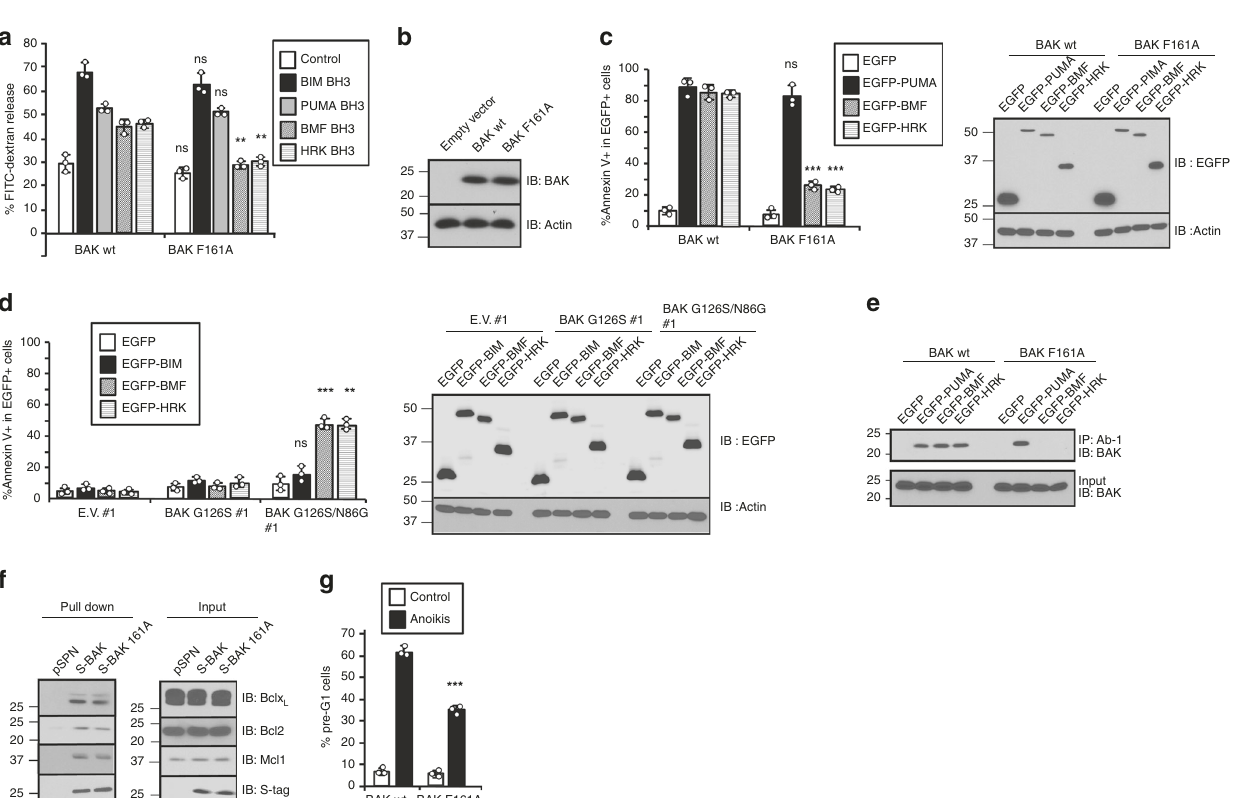
Fig. 7 Dependence of BMF- and HRK-induced apoptosis on the alternative BAK binding mode. a Liposome permeabilization assay performed in the presence of 50nM wild-type (WT) BAK Δ TM or BAK Δ TM F161A and 50nM of the indicated BH3 peptides. p = 0.24, 0.33, 0.20, 0.006, and 0.003 for control, BIM, PUMA, BMF, and HRK BH3s, respectively, when liposome release mediated by BAK F161A mutant was compared with WT BAK in the presence of the same BH3 peptide. b Bak − / − Bax − / − MEFs were transduced with the indicated retrovirus to express WT BAK and BAK F161A. After 2 weeks of selection, a pool of cells was subjected to western blot. c – e After the indicated EGFP-tagged BH3-only proteins were transfected into Bax − / − Bak − / − DKO MEFs reconstituted with WT BAK, F161A BAK c , e or empty vector (E.V.), BAK G126S without or with the reciprocal N86G mutation that restores BAK oligomerization 38 d , cells were harvested, stained with APC-conjugated Annexin V, and subjected to fl ow cytometry c , d . The percentages of EGFP + cells that are Annexin V + are indicated. p = 0.18, 0.0006, 0.0002 for PUMA, BMF, and HRK, respectively, when the percentages of Annexin V + cells reconstituted with BAK F161A were compared with those reconstituted with WT BAK c , and p = 0.10, 0.0009, 0.001 for BIM, BMF, and HRK, respectively, when the percentages of Annexin V + cells of reconstituted with BAK G126S/N86G were compared with those reconstituted with WT BAK d . In addition, cell lysates were prepared for immunoprecipitation with BAK Ab-1 antibody and blotting for BAK e . f After S-tagged WT or F161A BAK was transfected into MEFs for 24h, cell lysates were subjected to pull-down with S-protein agarose and blotting with the indicated antibodies. g Anoikis was induced for 48 h in Bak − / − Bax − / − DKO MEFs reconstituted with WT BAK or BAK F161A. The percentage of cells with sub-G1 DNA was assayed ( p = 0.0006). Right panels in c and d , whole-cell lysates subjected to immunoblotting. Error bars: mean ± S.D. of three independent experiments. ns, p >0.05; ** p <0.01; *** p <0.001, paired two-tailed t test for comparison of dextran release or cell death induced by mutants vs WT. Source data are provided as a source data fi